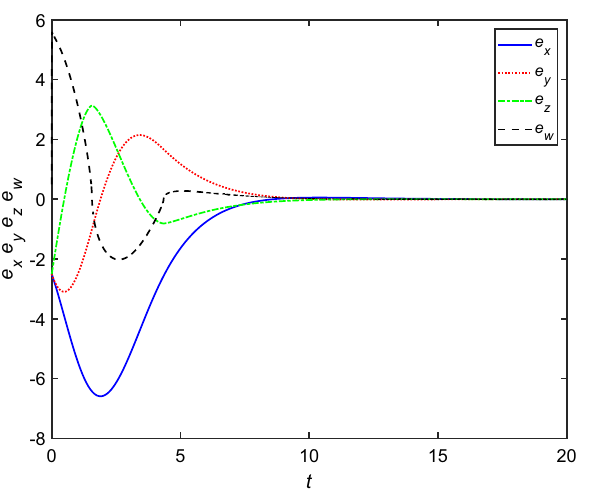
Fig. 5 The evolution of control